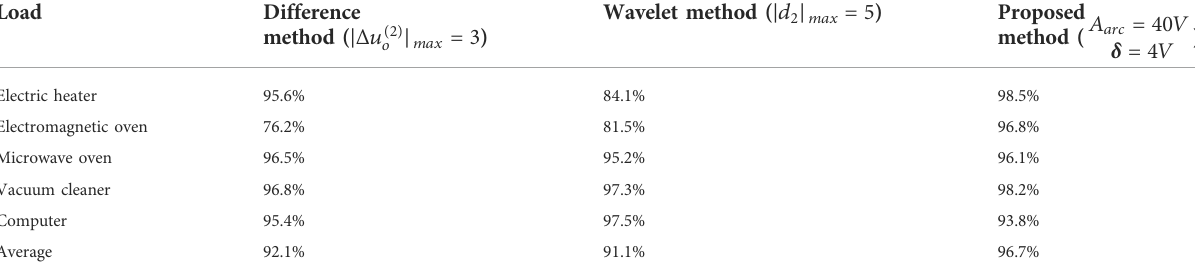
TABLE 3 Comparison of detection accuracy of related